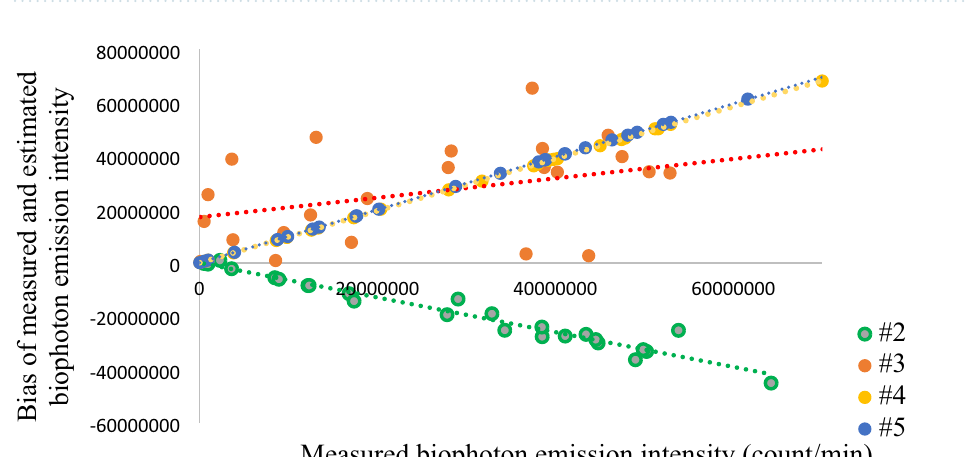
Figure 8. Scatterplot of measured biophoton emission intensity and the bias of measurement and estimation in the water-stressed group on Leaf B. There is a systematic error in the 2nd, the 4th and 5th time step. The systematic error can be estimated by linear regression